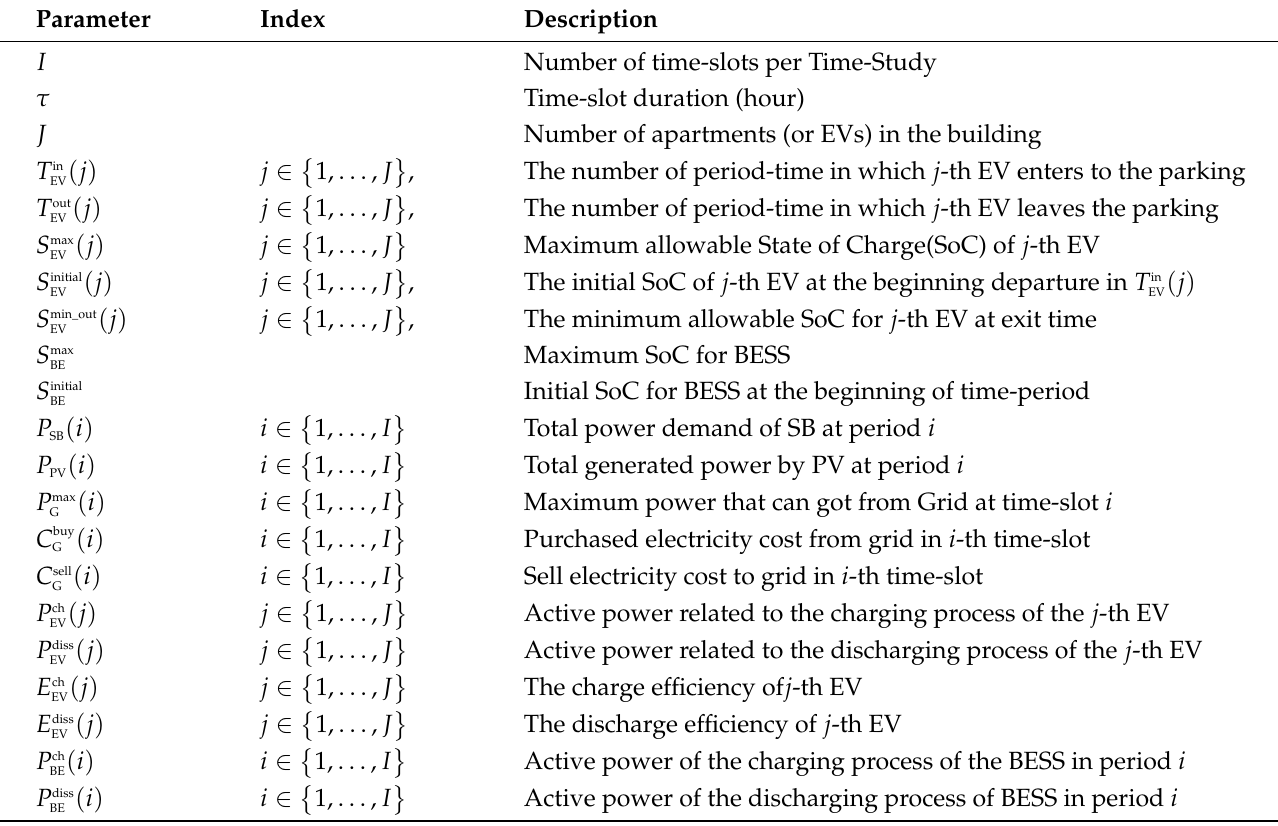
Table 1. Parameters of the